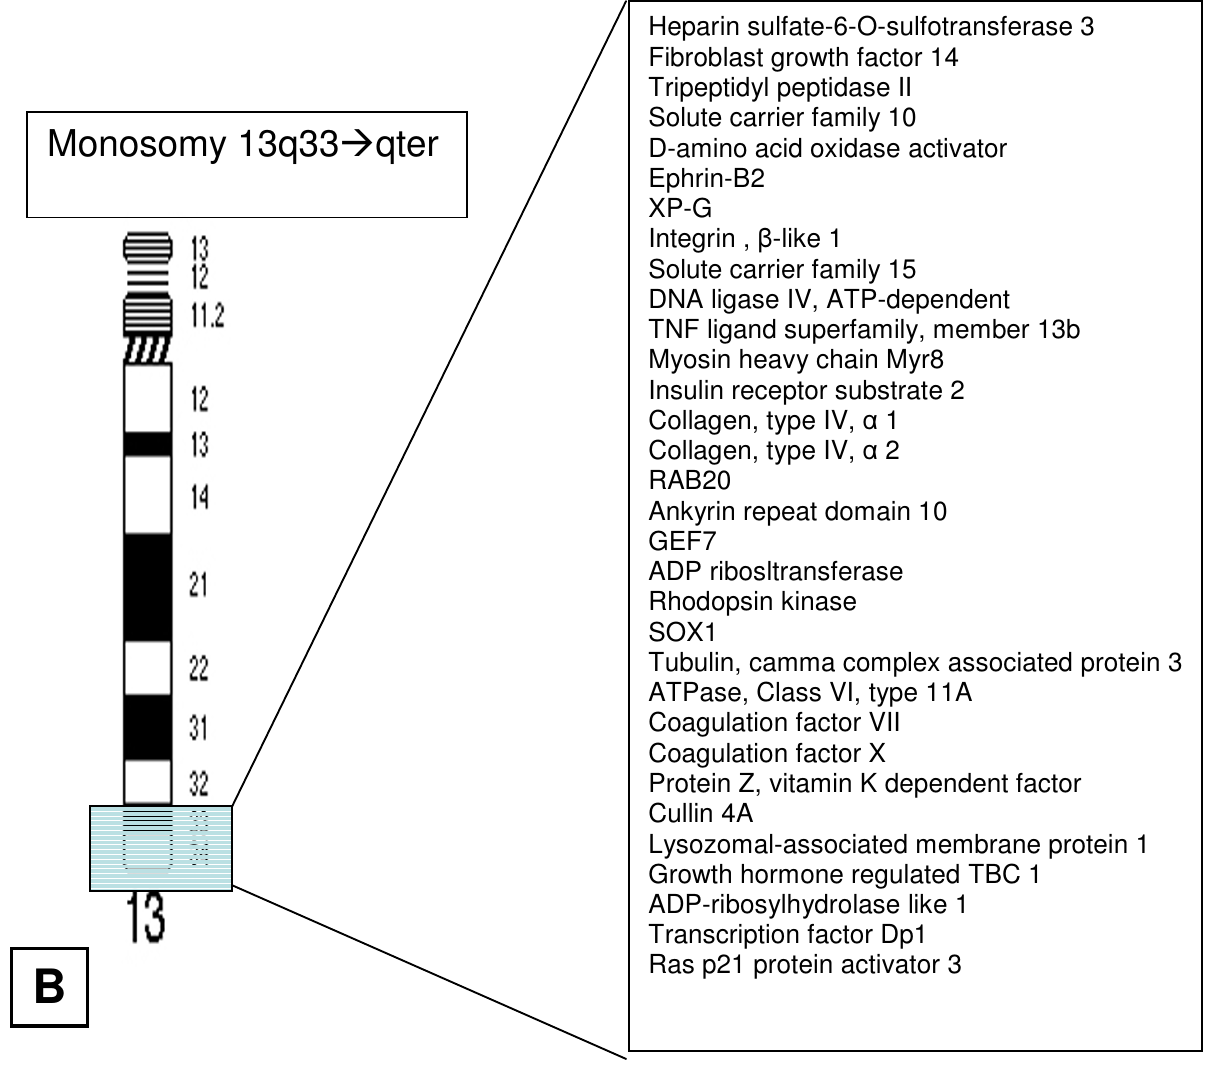
Ideogram of chromosome 13 with the monosomic region highlighted. Examples of genes known to map to these chromosomal segments are noted, according to the information in build 35.1 of the Homo sapiens sequence on the NCBI Map Viewer and Online Mendelian Inheritance in Man. Hypothetical proteins and open reading frames are omitted from the list. In some cases, the exact order of transcripts is